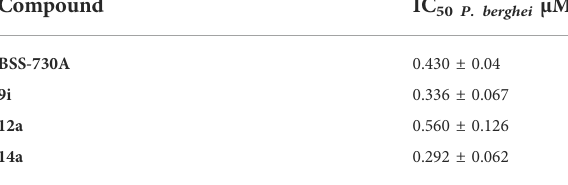
TABLE 7 Compound activity against the P. falciparum blood stage.